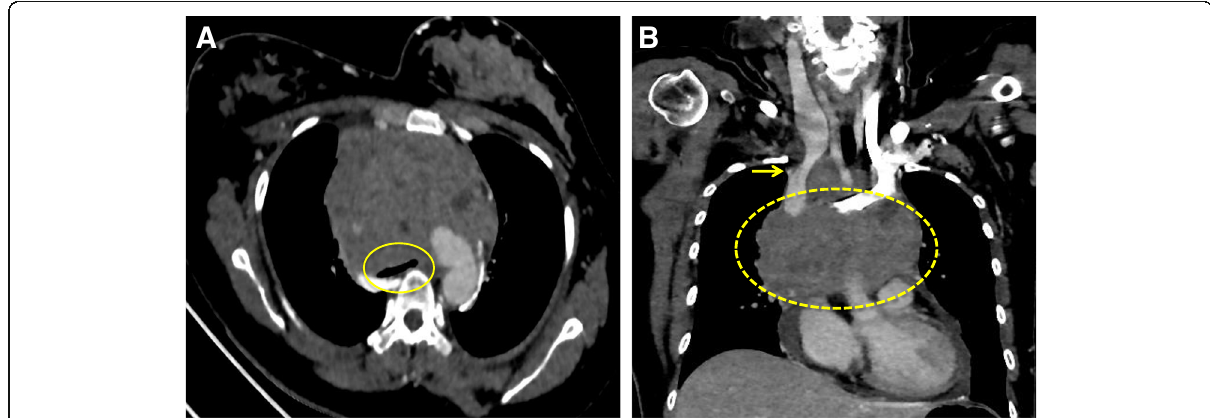
Fig. 1 a CT scan showing the mediastinal mass severely compressing the trachea ( solid line circle ). b Enhanced CT scan showing a large anterior-superior mediastinal mass [113×87×68 mm (length, height, width; dotted line circle )] compressing the superior vena cava ( yellow arrow